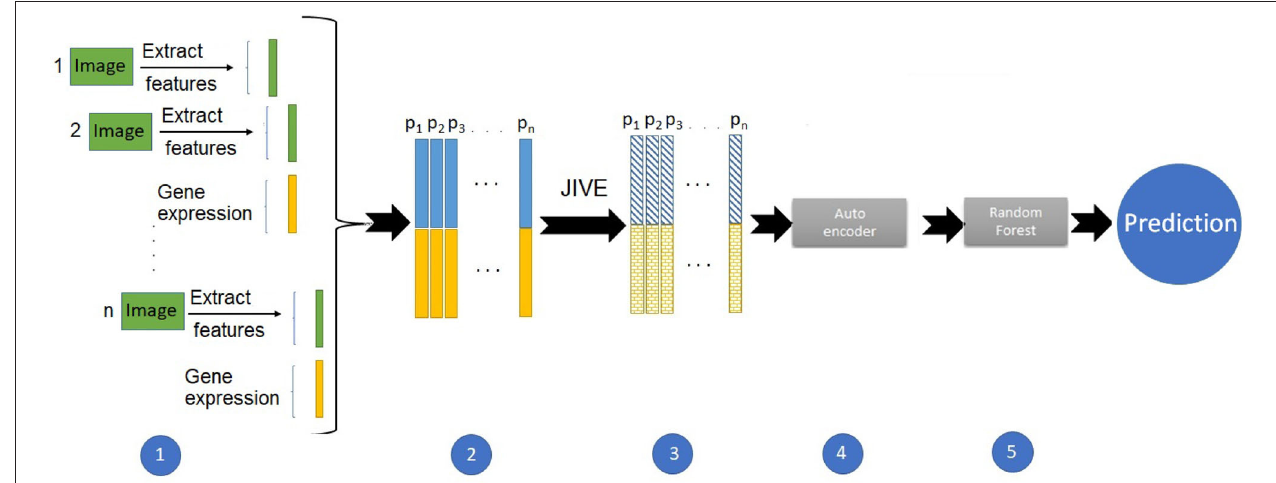
FIGURE 1 | Pipeline to build a prediction model with integrated imaging and expression